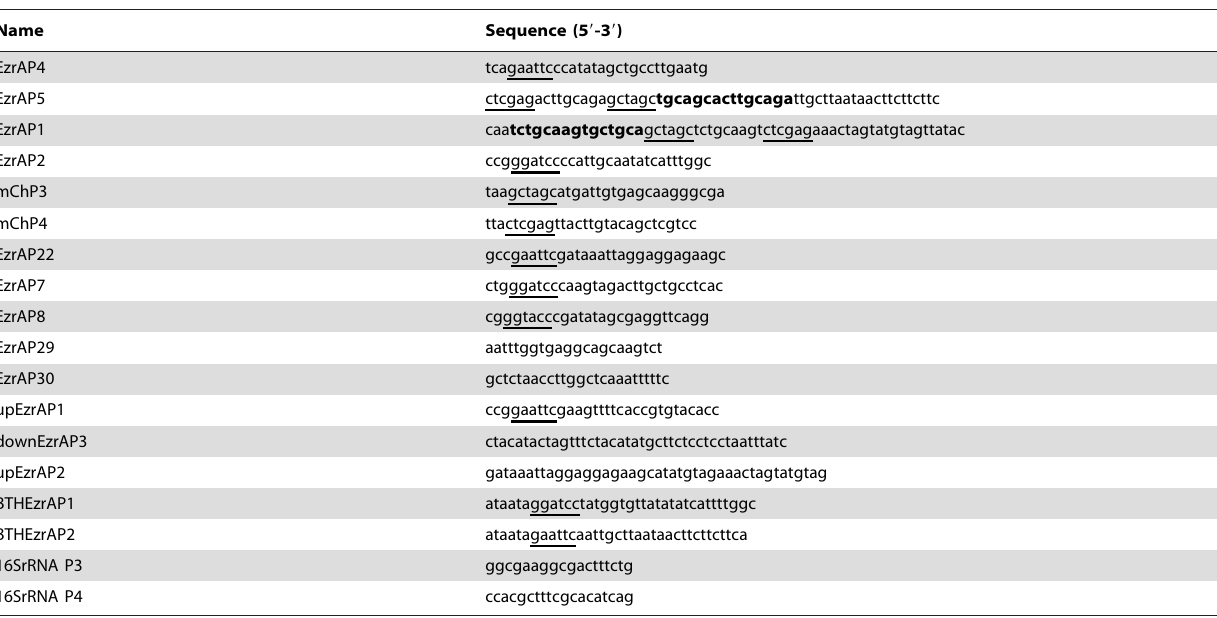
Table 3. Primers used in this